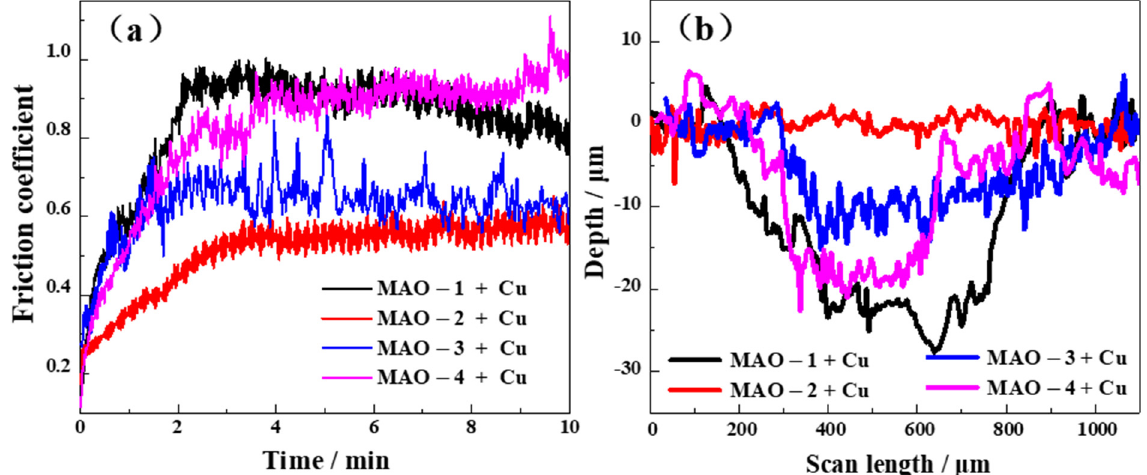
Figure 4. ( a ) Coefficient of friction of four composite coatings as a function of sliding time and ( b ) corresponding surface profiles of the wear tracks after friction test.